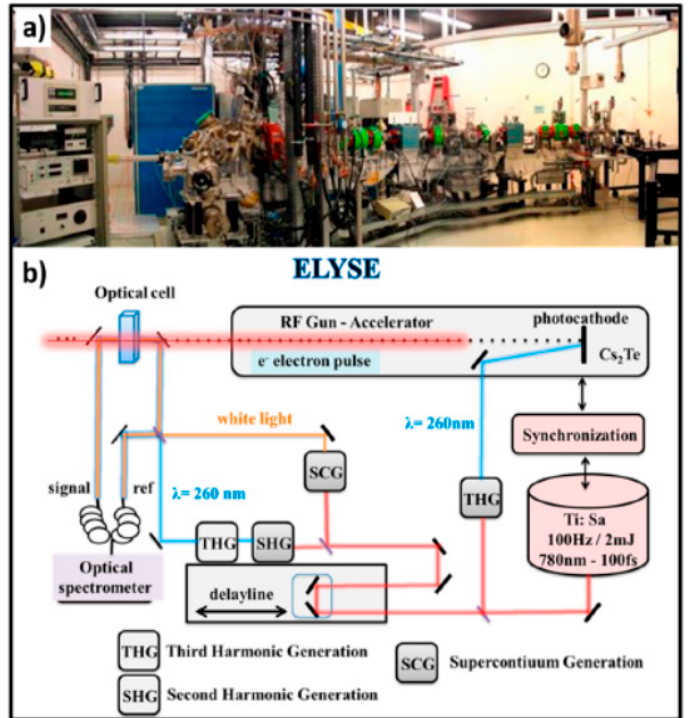
Figure 32. ( a ) Photograph of the pulse radiolysis facility (the only one in Europe) based on the